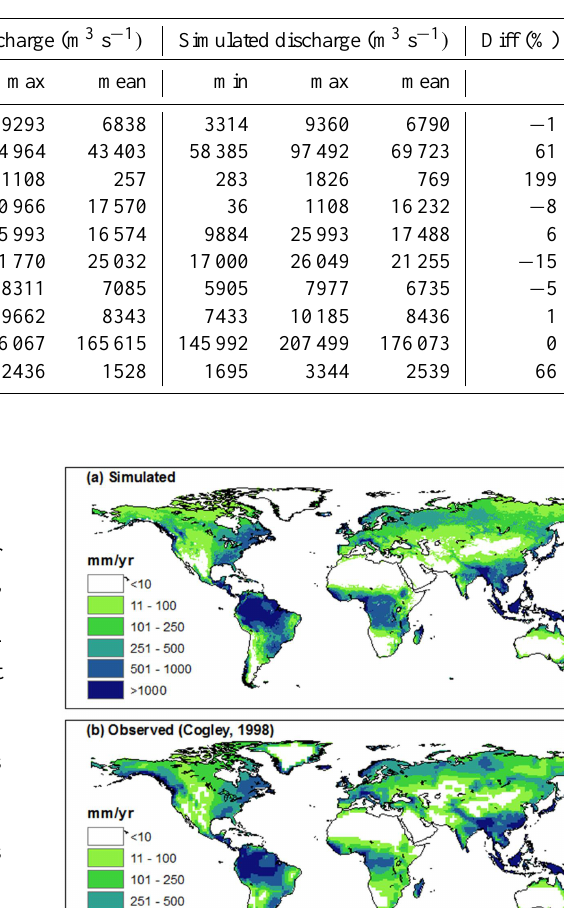
Table 7. Comparison between LH-simulated and observed annual discharges for 10 large rivers worldwide.